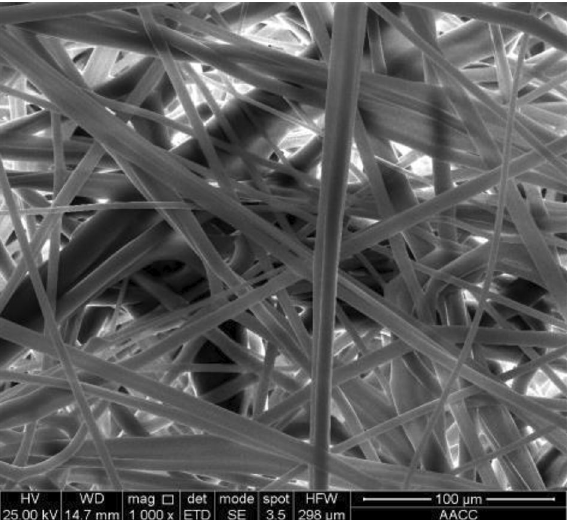
Figure 1. SEM image of the filter media under the magnification of